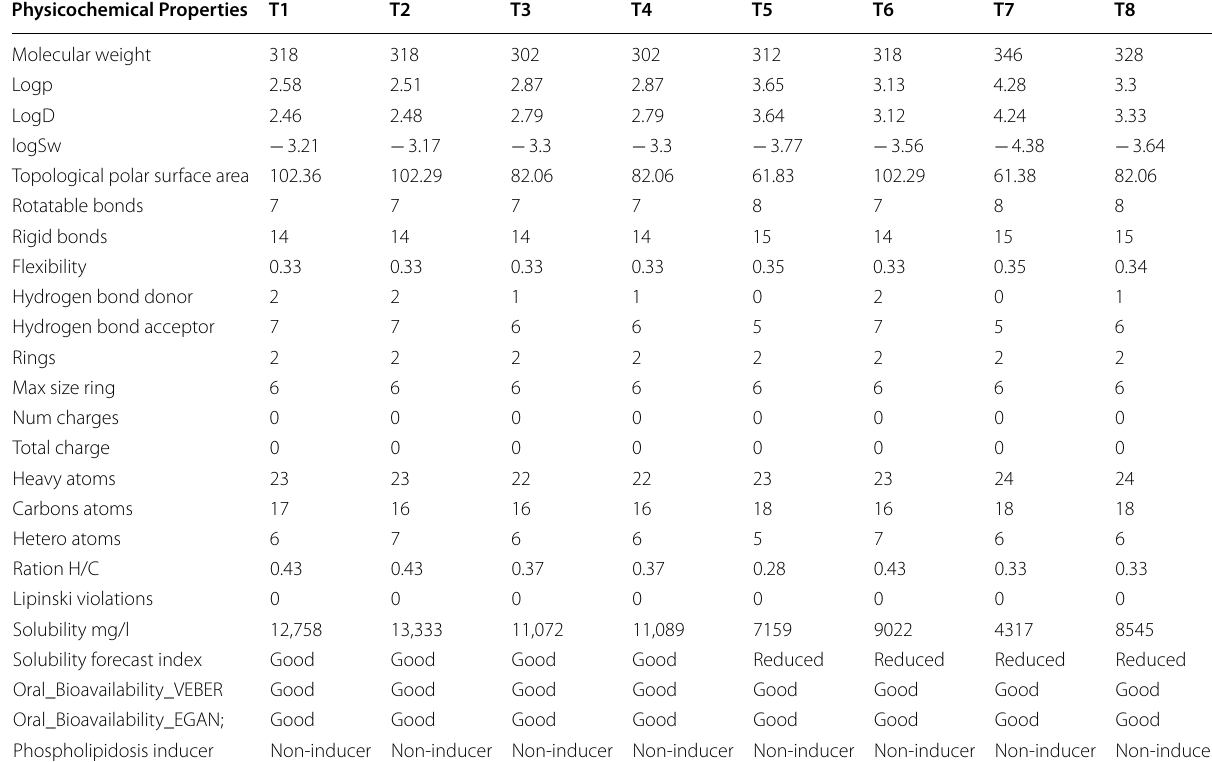
Table 1 Chemoinformatic properties of phenolic derivatives Physicochemical Properties T1 Molecular